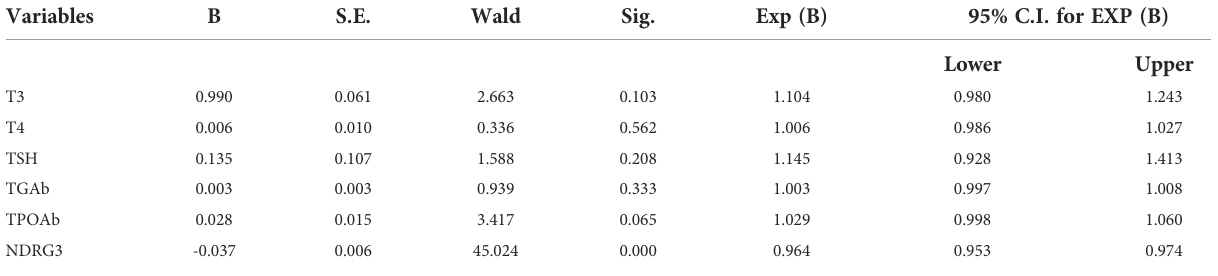
TABLE 2 Binary logistic regression Analysis of PTC and various factors.